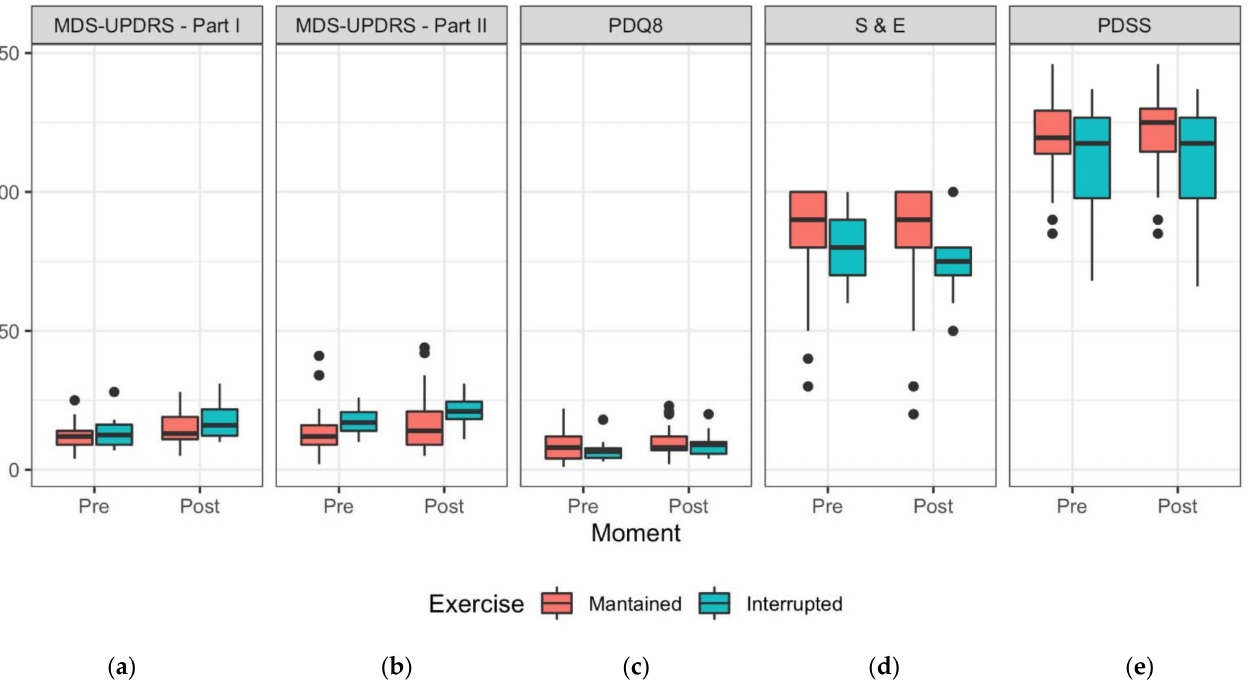
Figure 1. ( a ). Evaluation of cognition, behaviour and mood measured by Movement Disorders Society-Unified Parkinson Disease Ratting Scale Part I (MDS-UPDRS I) for pre- and post-assessment moments in terms of function of exercise habits. ( b ). Evaluation of motor aspects of experiences of daily living measured by Movement Disorders Society-Unified Parkinson Disease Rating Scale Part II (MDS-UPDRS II) for pre- and post-assessment moments in terms of function of exercise